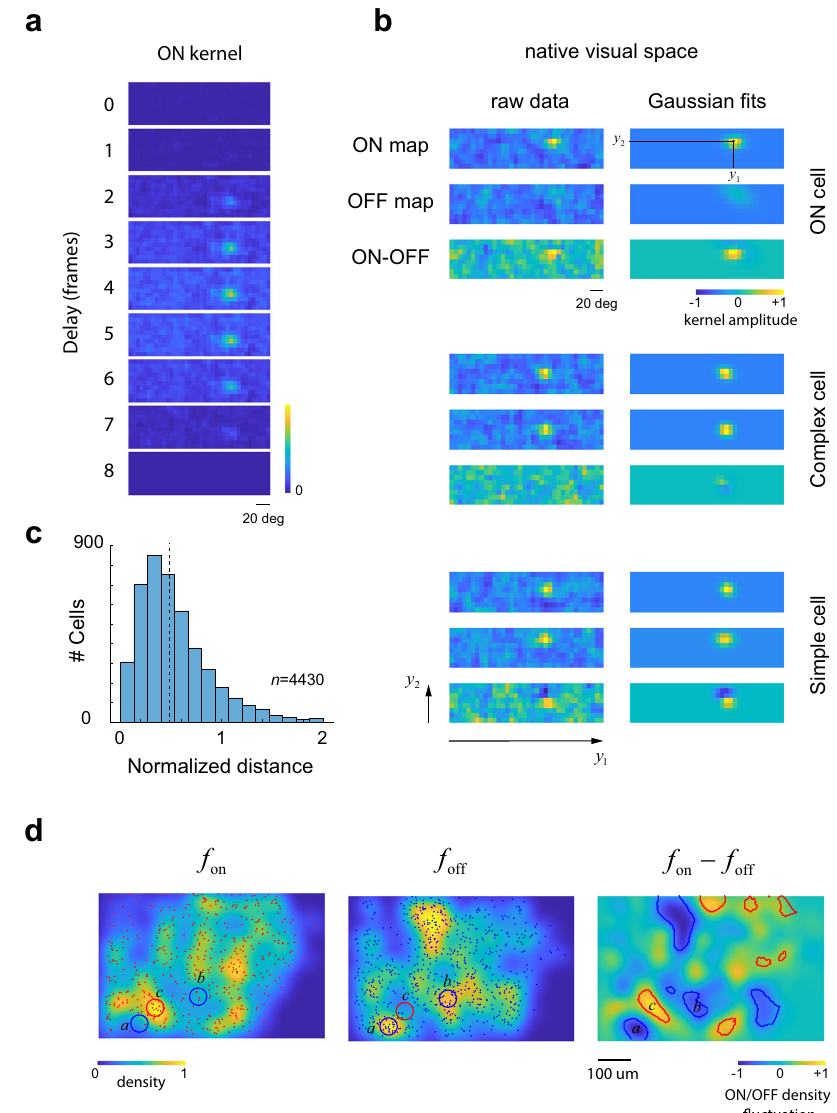
Fig. 2 Calculation of ON/OFF kernels and domains. a Example of a spatio-temporal ON kernel. The panels show the correlation between the response of a neuron and the location of the presentation of bright stimuli across the visual fi eld for different delay times between stimulus and response. The peak response, as measured by the norm of the kernel, occurs 4 frames (260 ms) after stimulus onset. Kernel is normalized between zero and one. b Raw receptive fi eld measurements (left panels) and their Gaussian fi ts (right panels). Top, Cell with only a signi fi cant ON kernel. Middle, a complex cell with largely overlapping ON and OFF kernel. Bottom, a simple cell with spatially displaced ON and OFF kernels. ON and OFF kernels are normalized jointly to the absolute value attained by either of them, thus the colormap ranges from 0 to 1 and the colormap in panel a applies. In the case of ON-OFF difference maps, we normalized by the maximum absolute value of the map, thus the colormap ranges from − 1 to + 1. c Distribution of normalized distance in V1 neurons with signi fi cant ON and OFF maps in n = 4430 neurons pooled across all experiments. Normalized distance is de fi ned as the distance between receptive fi eld centers divided by the average sigma of the Gaussian fi t. We de fi ne simple cells as those with a normalized distance larger than one half. d Demonstration of ON/OFF domains in native cortical space. The image on the left shows the distribution of ON cells on the cortical surface (we are projecting depth away) along with a pseudo-colormap showing the estimated density. The density estimation for OFF cells appears in the middle panel. Note that both densities appear to peak at different locations. Blue circles show two peak locations for the density of OFF cells. The red circle shows a peak location for ON cells. ON/OFF domains are evident in the difference of the densities, as shown in the right image. Level sets depict areas where the fl uctuations exceed what might be expected by chance at a 0.001 level by randomly shuf fl ing the ON/OFF labels of the cells (without changing their positions). Source data provided for panel c Alignment of visual and cortical spaces via canonical correla- of ON/OFF inputs with receptive fi elds centers displaced tion analysis . To test the predictions of the model we fi rst bring vertically. Thus, a biased input constrains the shape of the cortical and visual fi elds into alignment using canonical correlation receptive fi elds the cortex can develop 27 . Moreover, under mild analysis 35 , which yields two linear transformations of the data. conditions, the model predicts the average receptive fi eld of simple cells in a cortical volume should correlate with the average of the ON/OFF signals within its neighborhood 27,30,34 .